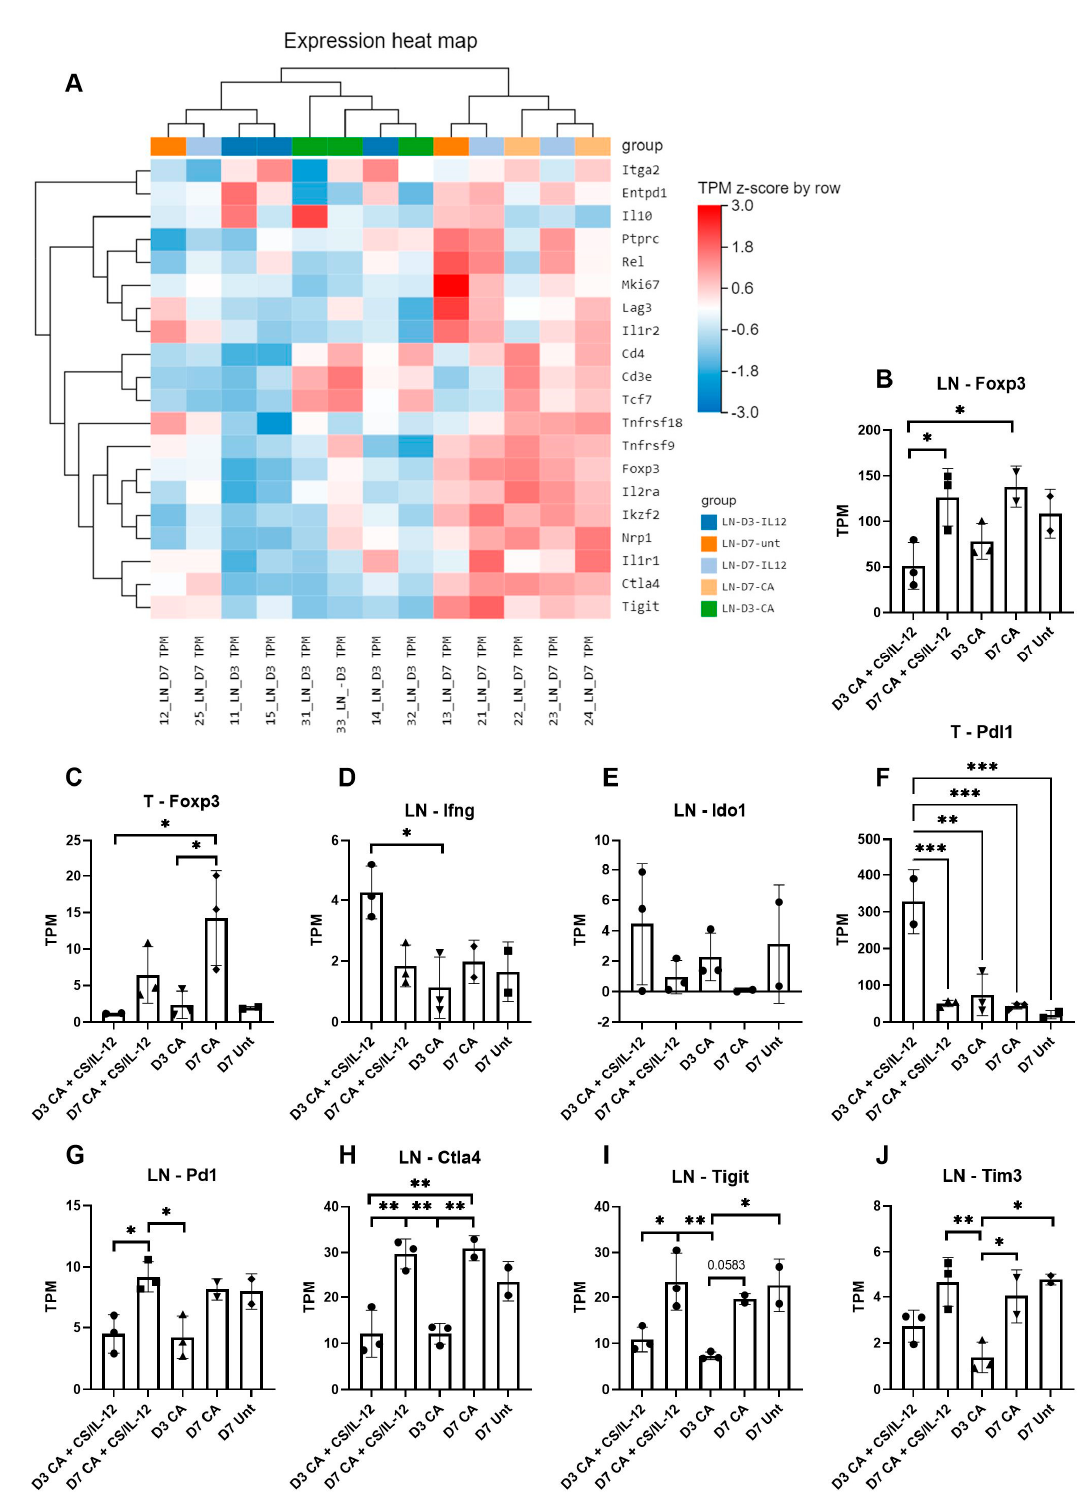
Figure 6. Immune regulation increases over time. Mice bearing MC38 tumors were treated as indicated and then tissue samples were acquired on day 3 (D3) or day 7 (D7) post treatment. The unit of measure is transcripts per kilobase million (TPM) using z-score (row direction) as the standardization method and the horizontal axis was sorted based on cluster order. Gene expression of a subset of genes associated with regulatory T cells was quantified as TPM and standardized using log2 (value + 1). The results are displayed as a heatmap using all LN samples ( A ). A quantitative comparison of selected genes was performed based on TPM values ( B – J ). Foxp3 was assessed in both the LN ( B ) and tumor ( C ) samples, Ifng ( D ) and Ido1 ( E ) were analyzed in the LN